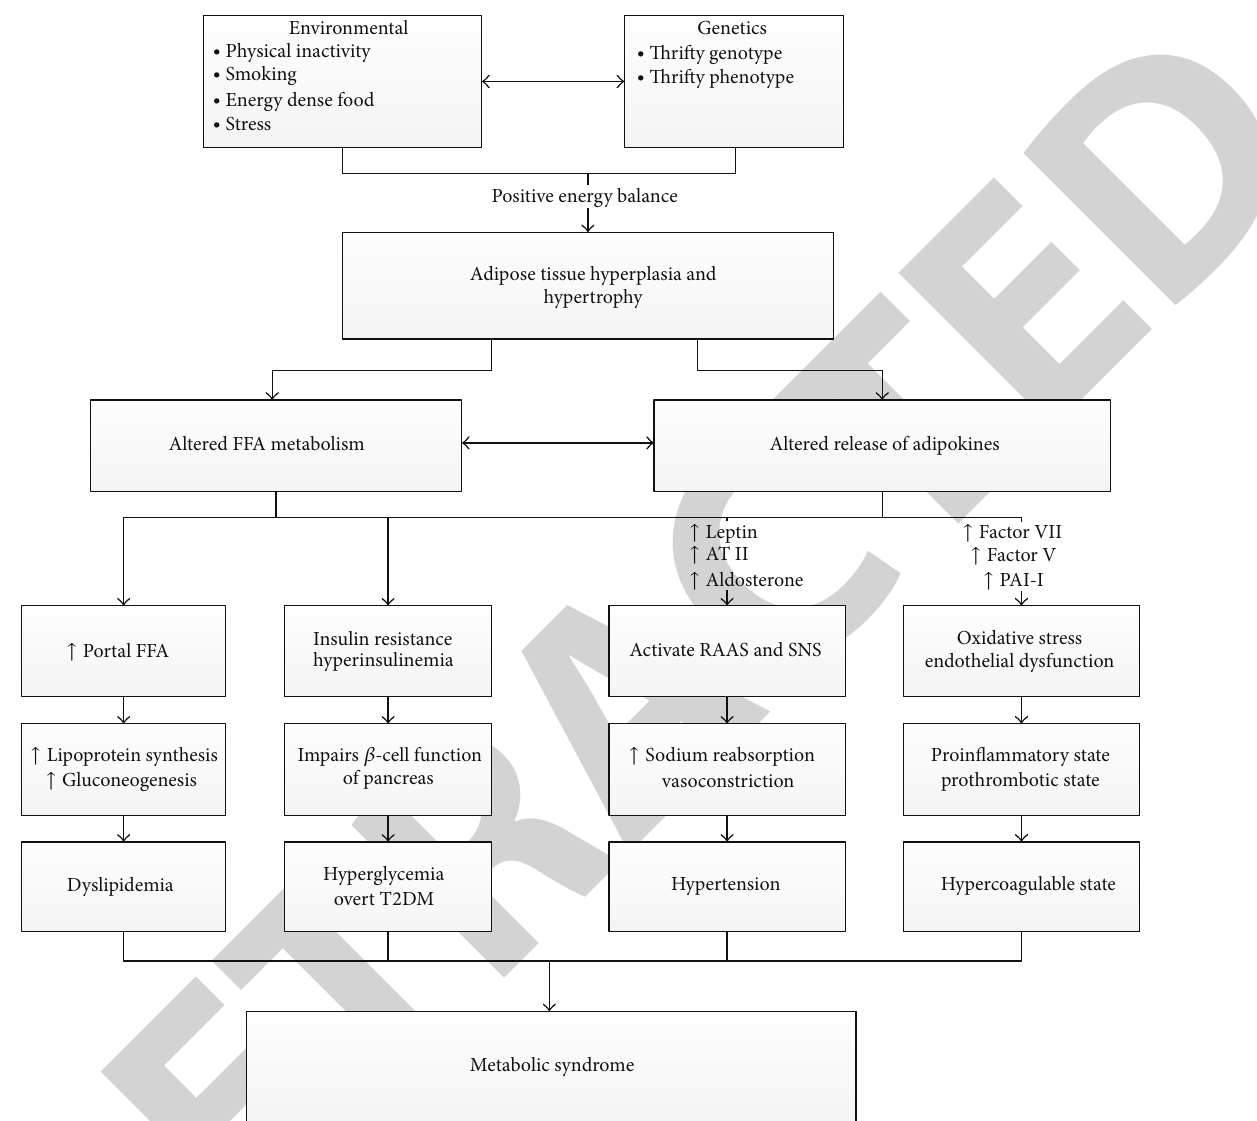
Figure 1: Schematic presentation of MetS. (FFA: free fatty acid, ATII: angiotensin II, PAI-1: plasminogen activator inhibitor-1, RAAS: renin angiotensin aldosterone system, SNS: sympathetic nervous